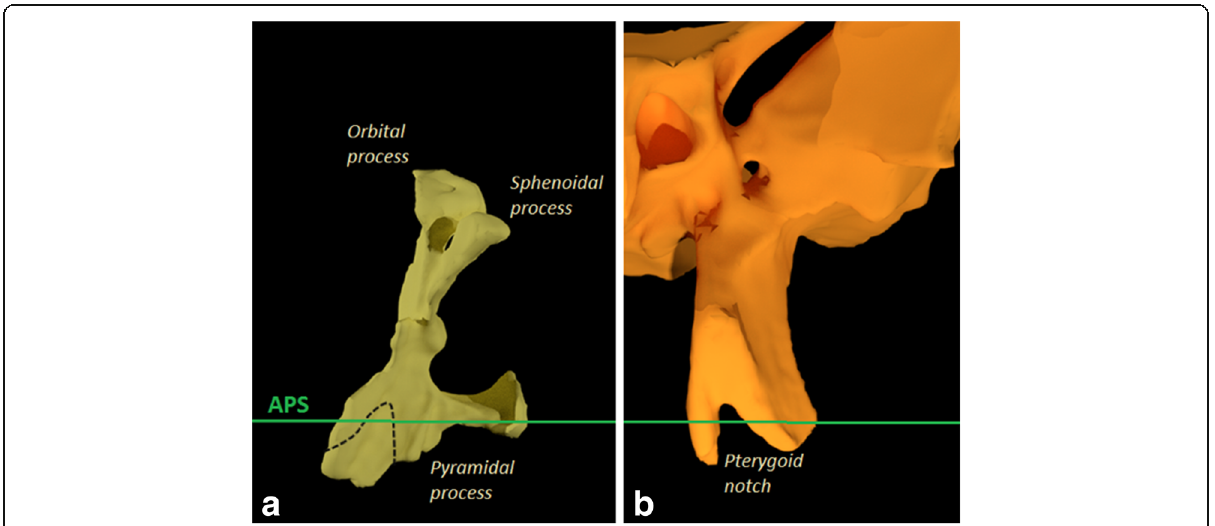
Fig. 8 Relation between the APS with palatine bone and pterygoid plates. a Posterior view of the left palatine bone. b Anterior view of the left pterygoid process of the sphenoid bone